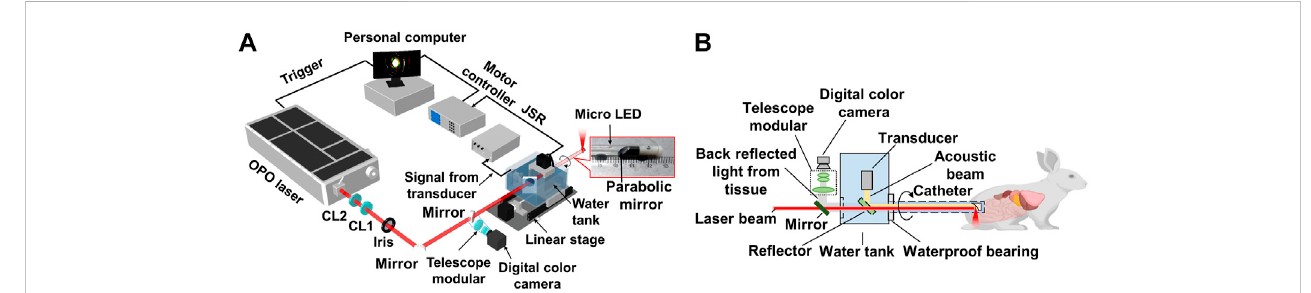
FIGURE 1 SystemsetupofthemultimodalAR-PA/USEandwide- fi eldopticalimagingsystem. (A) Schematicillustrationofthesystem; (B) Illustrationofthesystem ’ s laser incidence, ultrasound detection, wide- fi eld optical endoscopic imaging schemes, and a photograph of the probe ’ s distal end. CL1, positive cylindrical lens; CL2, negative cylindrical